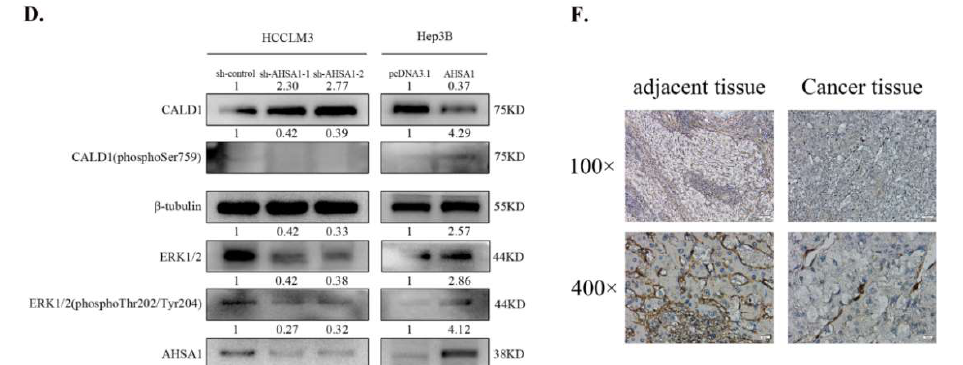
Figure 4. AHSA1 promoted the phosphorylation and inactivation of CALD1 by phosphorylation of ERK1/2 ( A ). EMT markers were analyzed by Western blot by changing AHSA1 expression in HCC cells. ( B ). Proteins that may interact with AHSA1 were obtained by qualitative mass spectrometry. ( C ). AHSA1-ERK1/2-CALD1 was analyzed using Co-IP of the Hep3B cell lysate and Western blot. ( D ). Protein levels of downstream molecules in HCC cells with AHSA1 knockdown or overexpression were analyzed by Western blot. ( E ). CALD1 protein expression in HCC cells lines and normal immortalized liver epithelial cells were analyzed. ( F ). Representative IHC images of CALD1 expression in cancer and adjacent tissues from HCC patients. The uncropped blots are shown in Supplementary Materials.